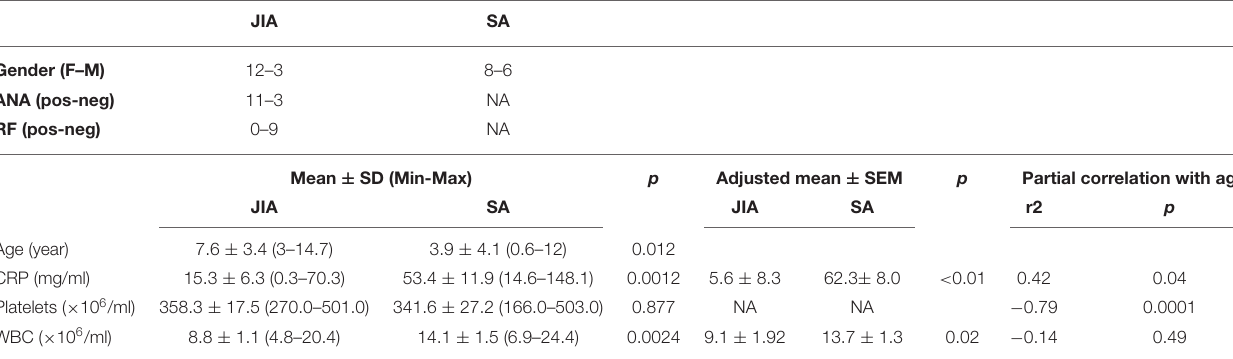
TABLE 1 | Characteristics of the enrolled